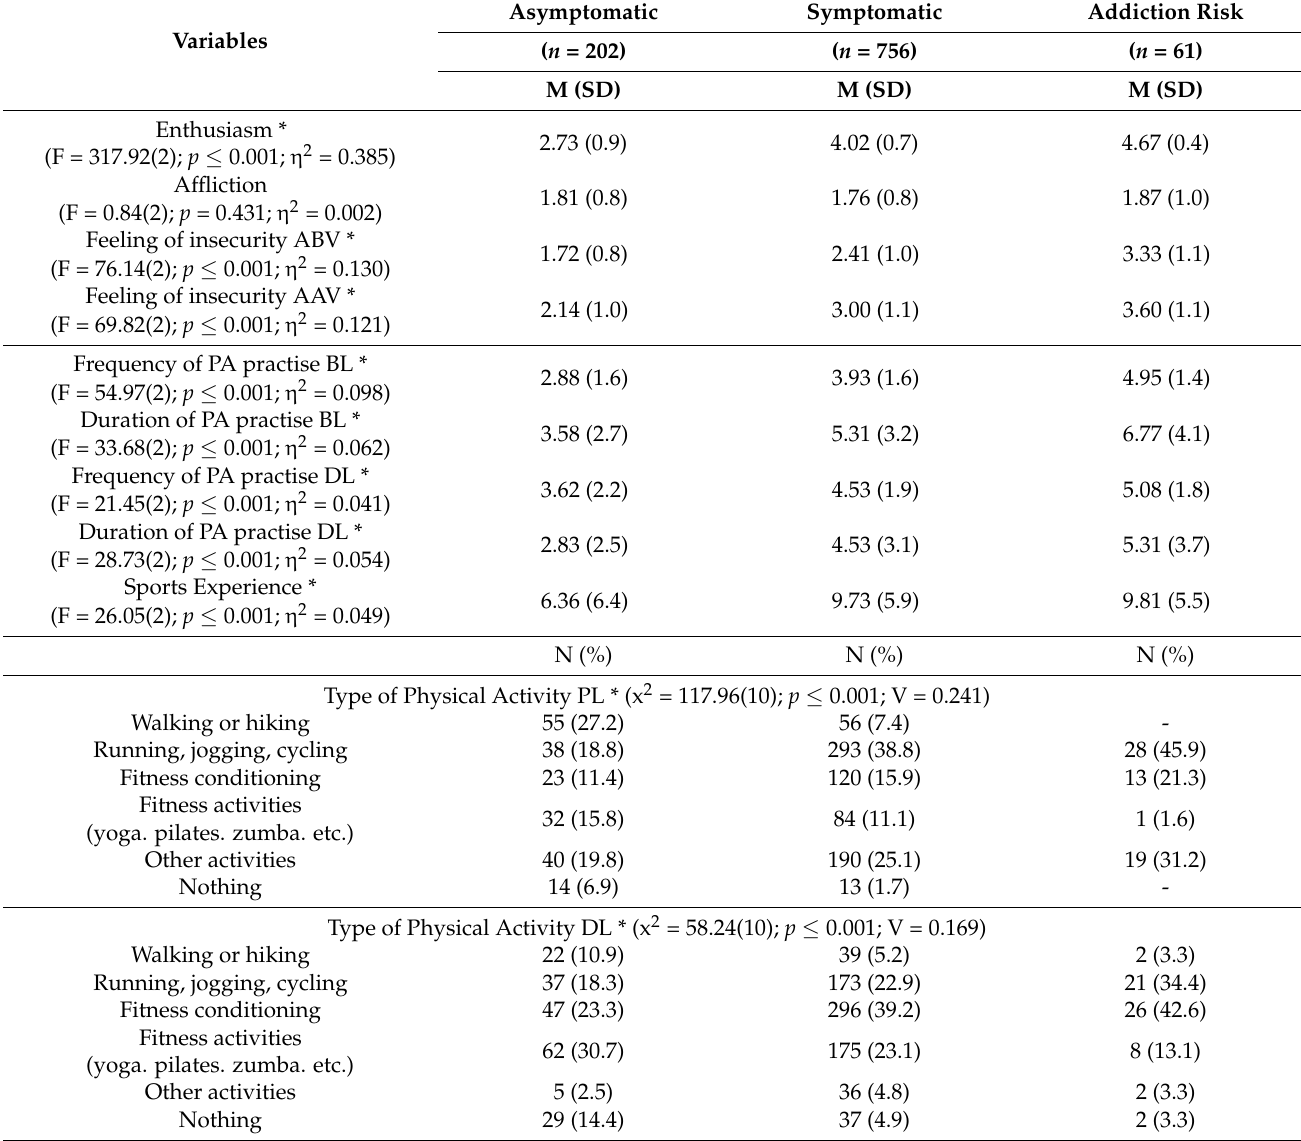
Table 2. Sports profile of participants by exercise addiction